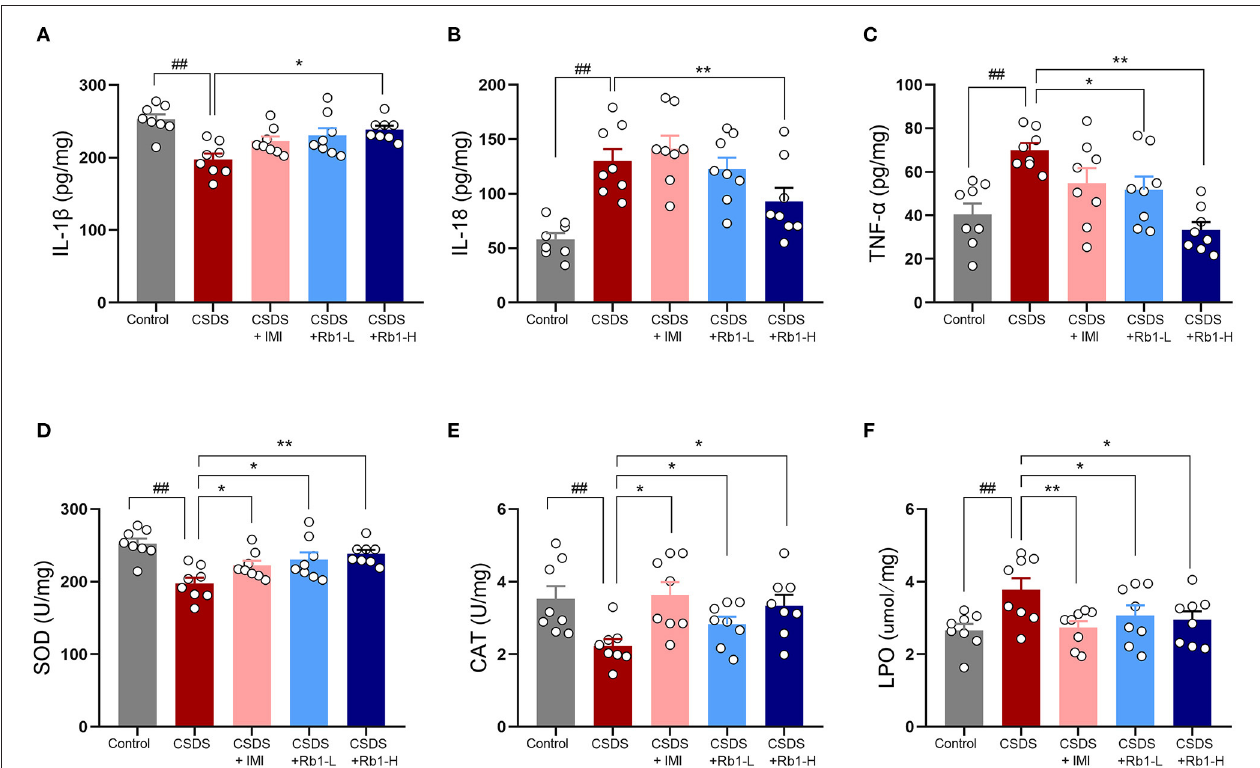
FIGURE 3 | Ginsenosides Rb1 and their effects on inflammatory and oxidative stress markers in CSDS mice; (A) Expression of IL-1 β ; (B) Expression of IL-6; (C) Expression of TNF- α ; (D) SOD activity; (E) CAT-related activities; (F) Activity at the LPO level in the hippocampus. The entire data has been presented are means ± SEM; N = 10 mice per group. ## p < 0.01, considerably differed from control; * p and ** p < 0.05, and 0.01, significantly varied from CSDS